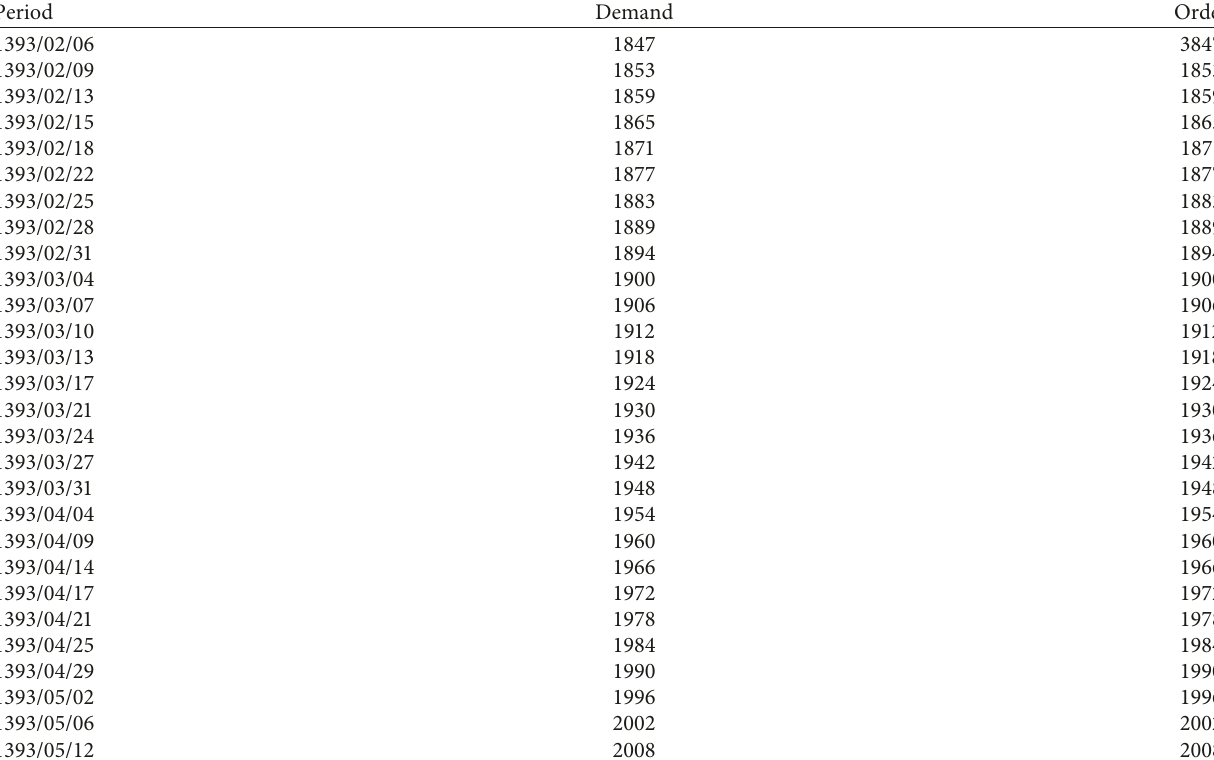
Figure 8: Diagram of correlation of Zarbal distribution agency Table 12: Forecasting Zarbal Company agency by the linear regression method.